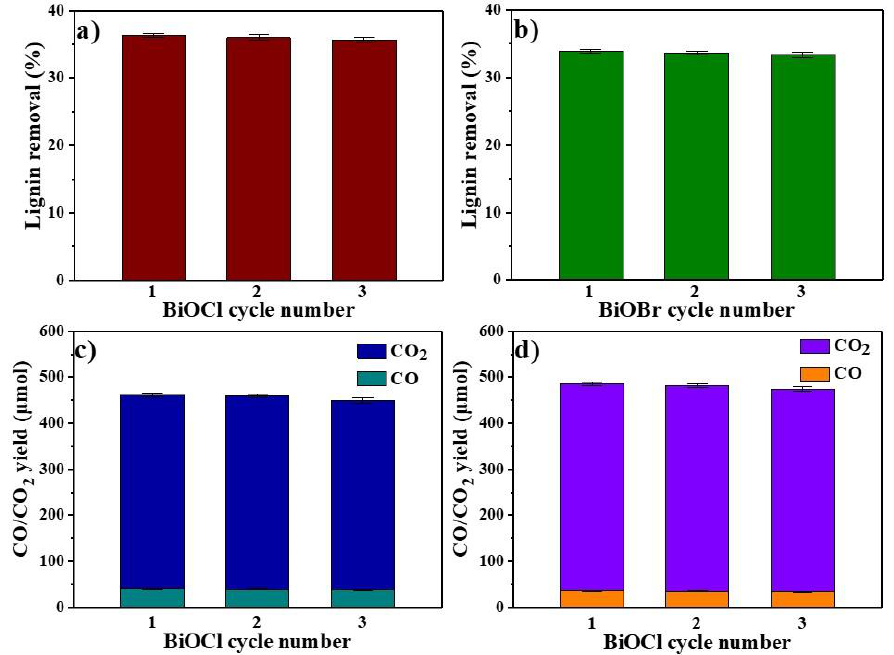
Figure 9. Lignin removals from PHL by cycled ( a ) BiOCl and ( b ) BiOBr; yield of CO/CO 2